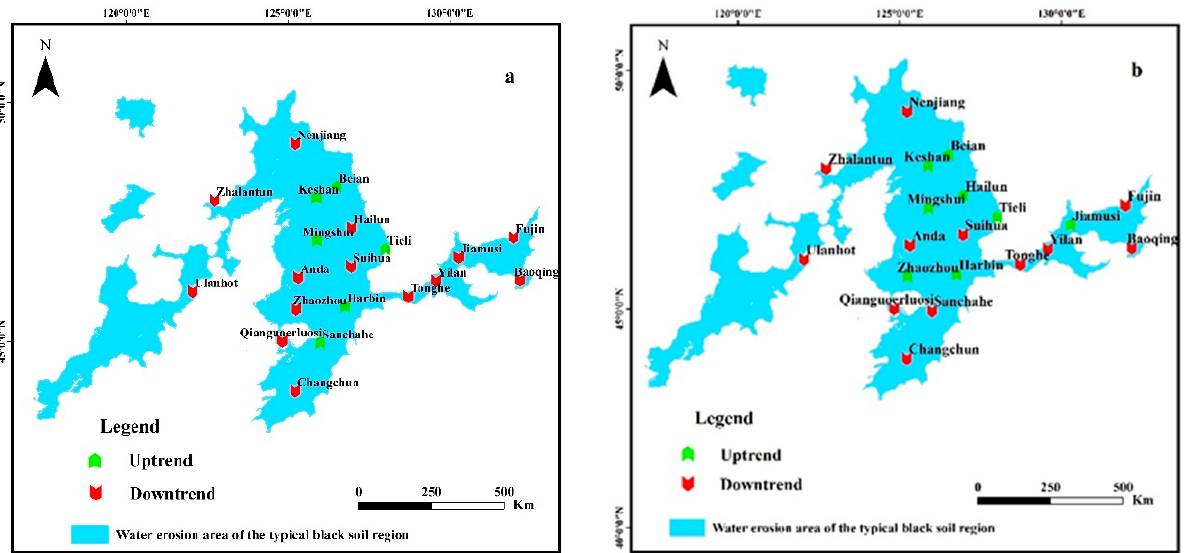
Figure 5. Mann–Kendall trend test of wind speed in water erosion area of the typical black soil region from 2001 to 2020 (( a ): mean annual wind speed, ( b ): maximum annual wind speed).